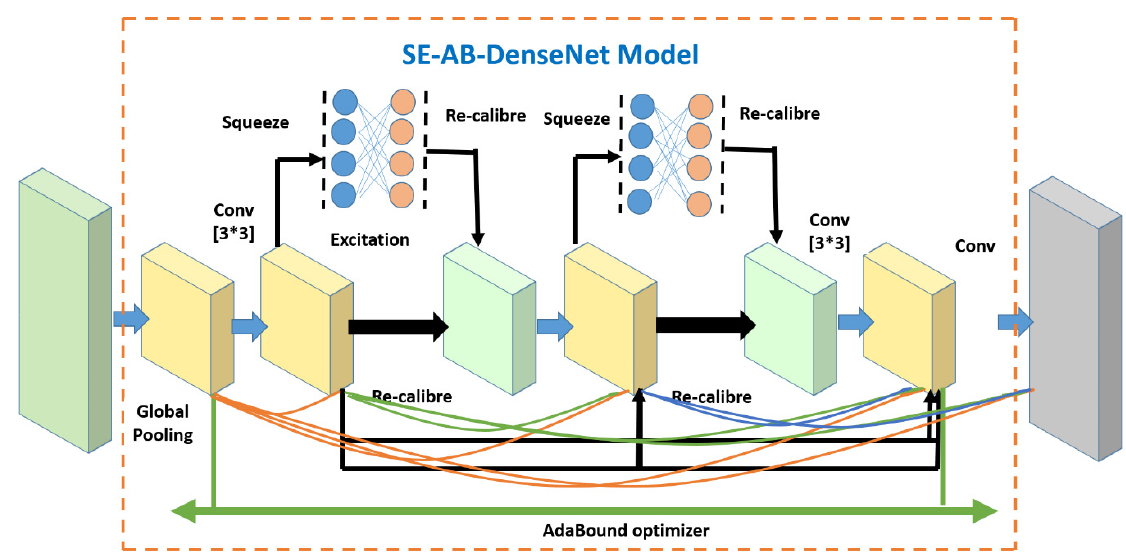
Figure 5. Proposed overall block diagram of SE-AB-DenseNet with cutout classifier.